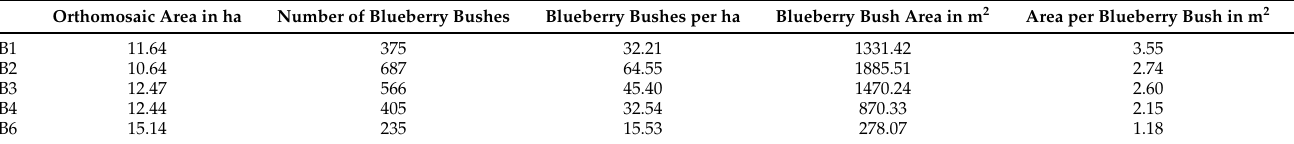
Table 1. Area and counting measures of blueberry bushes detected in the